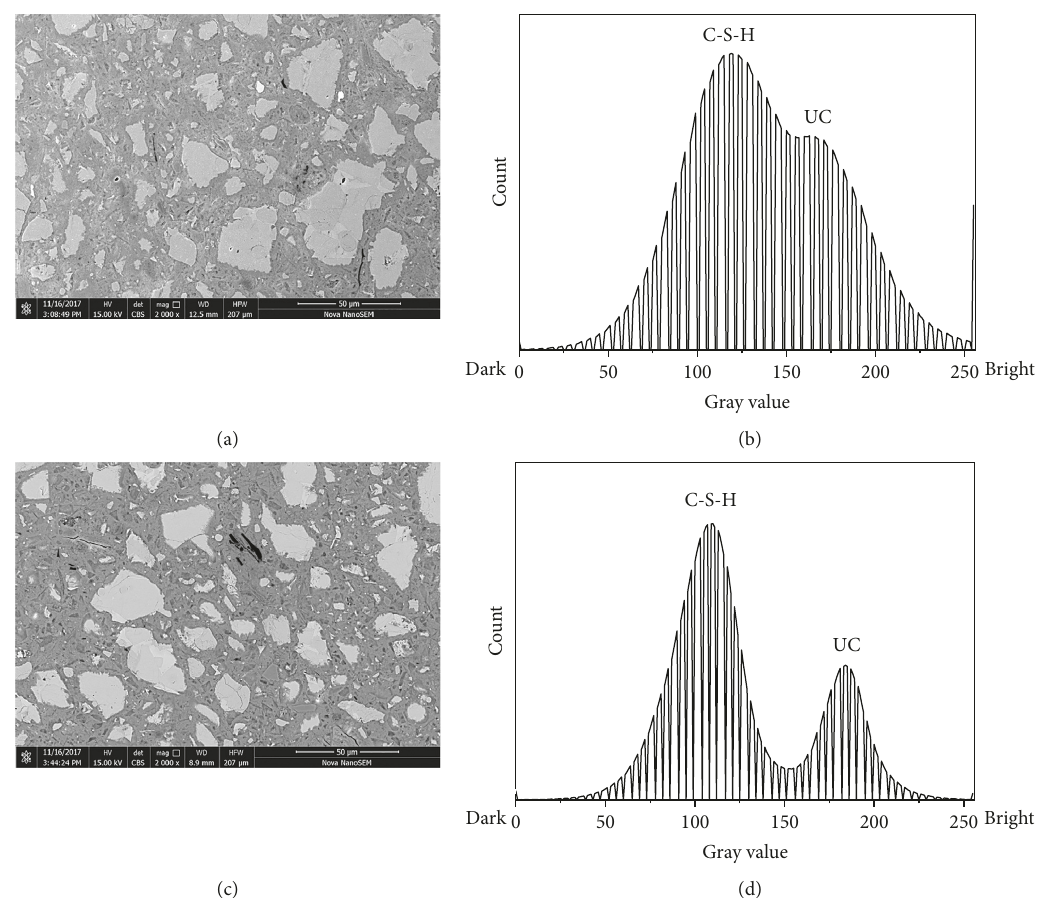
Figure 9: The BSE image (a) and grey level histogram (b) for SF10. The BSE image (c) and grey level histogram (d) for